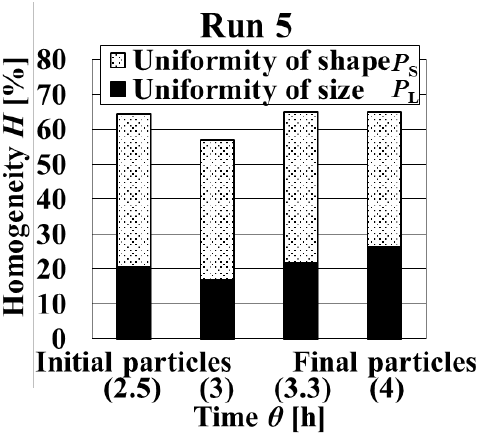
Figure 13. Dynamic variation in homogeneity and uniformity of distributions of particle size and crystal shape with the crystallization time in Run 5.